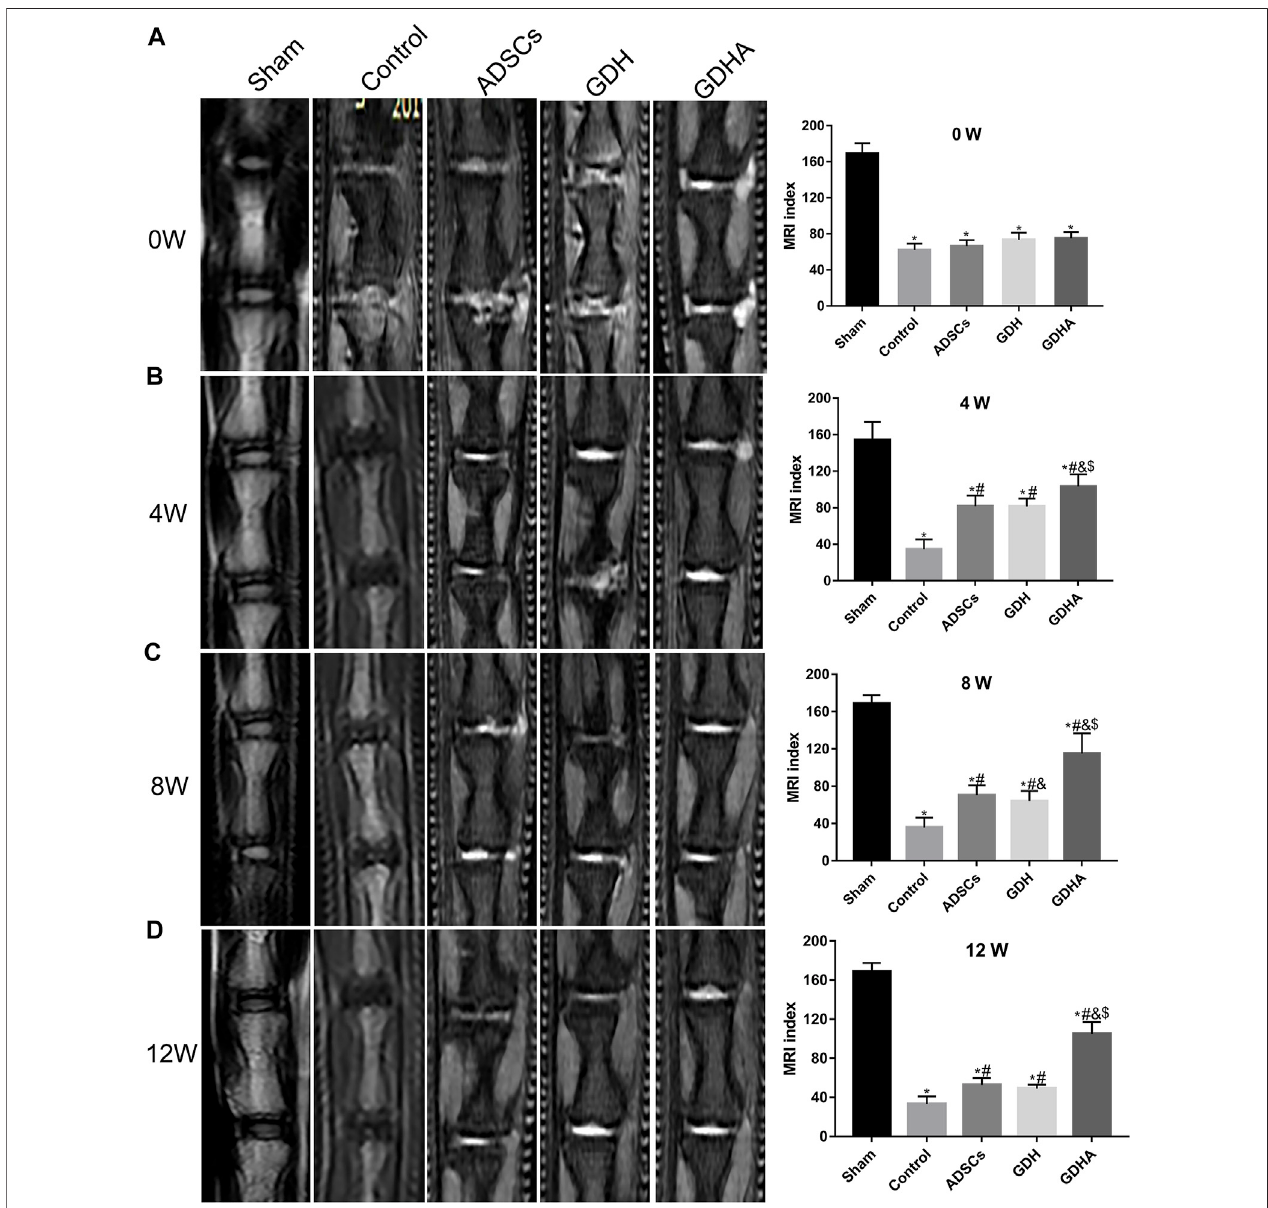
FIGURE7| TypicalMRIandMRIindexchangeinthetaildiscsat0 (A) ,4 (B) ,8 (C), and12 (D) weeksafterinjection.Datarepresentedmean ± SD(n (cid:2) 5);* p < 0.05, vs. sham group; # p < 0.05, vs. control group; & p < 0.05, vs. ADSCs group; $ p < 0.05, vs. GHD group.